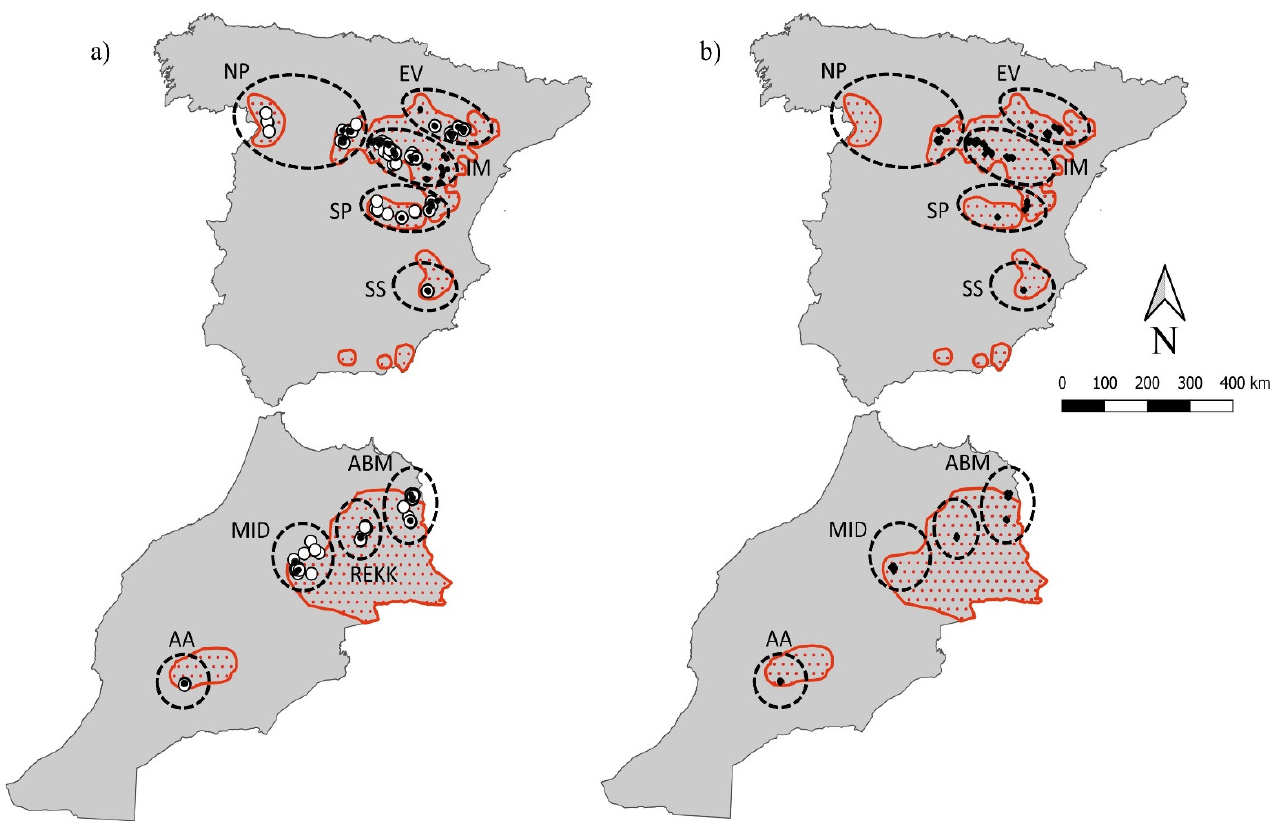
Figure 1. Limits of the nine regions (dashed lines) considered in this study and sampling locations of Dupont´s lark males (dots) within the Dupont´s lark distribution (red dotted polygons, obtained from [35,43]): ( a ) White dots represent samples collected during 2005–2006 (recent past period) and black dots represent samples collected during 2017–2020 (current period); ( b ) restricted set of sam- ples (black dots) that overlapped geographically between the two study periods. Spanish regions: Northern Plateau (NP), Ebro Valley (EV), Iberian Mountains (IM), Southern Plateau (SP), and South- ern Spain (SS). Moroccan regions: Aïn Bni Mathar (ABM), Plateau of Rekkam (REKK), Midelt-Mis- sour (MID), and Anti-Atlas (AA). Table 1. Genetic diversity estimates for each of the nine Dupont´s lark regions during the recent past (P) and the current (C) sampling periods, showing sample size (N), number of alleles (A), ob- served heterozygosity (H o ), unbiased expected heterozygosity (uH e ), allelic richness (A R ), p values for Hardy–Weinberg equilibrium (HWE) tests (significant values after Bonferroni correction in bold), inbreeding coefficient (F IS ), number and percentage (in brackets) of private alleles (Ap), and number and percentage of rare alleles (R A ). Significant F IS values are represented with an asterisk. The number of private and rare alleles lost (Ap_losses/R A _losses) and gained (Ap_gains/ R A_ gains ) is indicated (see main text for further details of calculations). Of the Ap_losses count, those that are completely lost at the metapopulation level in the current period are in brackets. Of the Ap_gains count, those already detected in any other region in the recent past period are in brackets. The pop- ulation size (census size) of each region is also indicated. The result of the bottleneck analysis, using the two-phase mutation model (TMP) and the Wilcoxon 1-tailed test for heterozygosity excess is also shown (significant results in bold). Region codes as in Figure 1. See Supplementary material, Table S2 for further information about allele frequencies.